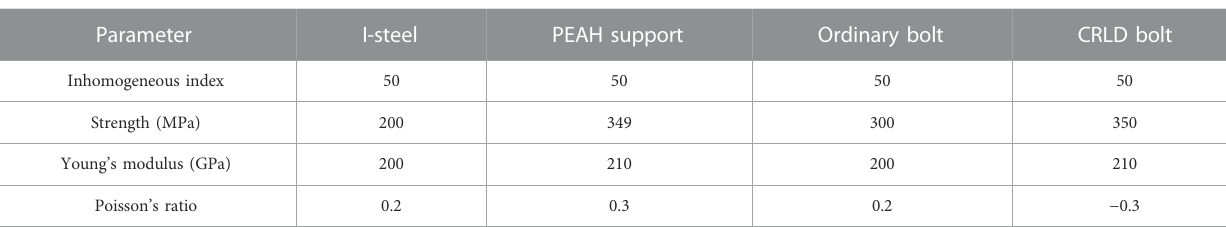
TABLE 2 Mechanical properties of support